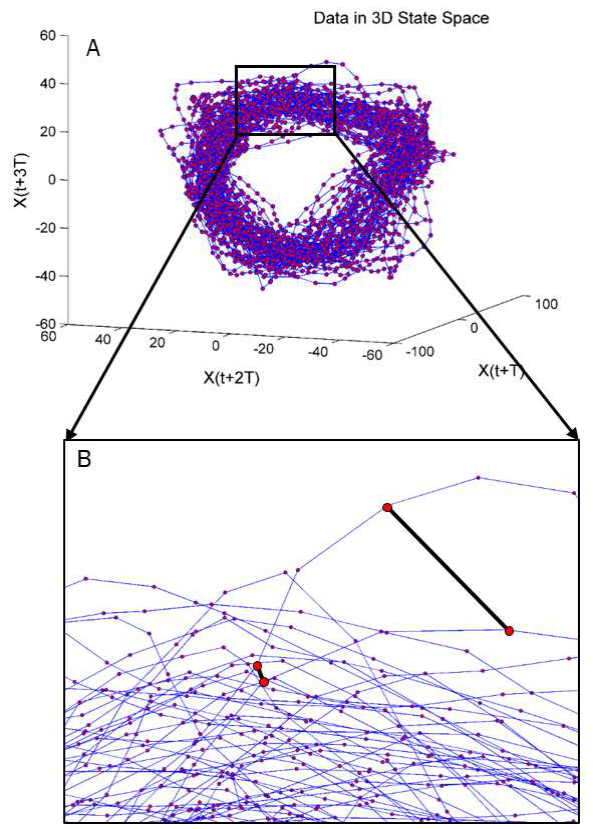
Figure 4. Force profile data X(t) transformed into 3D state space ( A ). Zoomed in view ( B ) with the distance between trajectories highlighted in black. X(t+T) represents force data shifted by the time lag, tau.